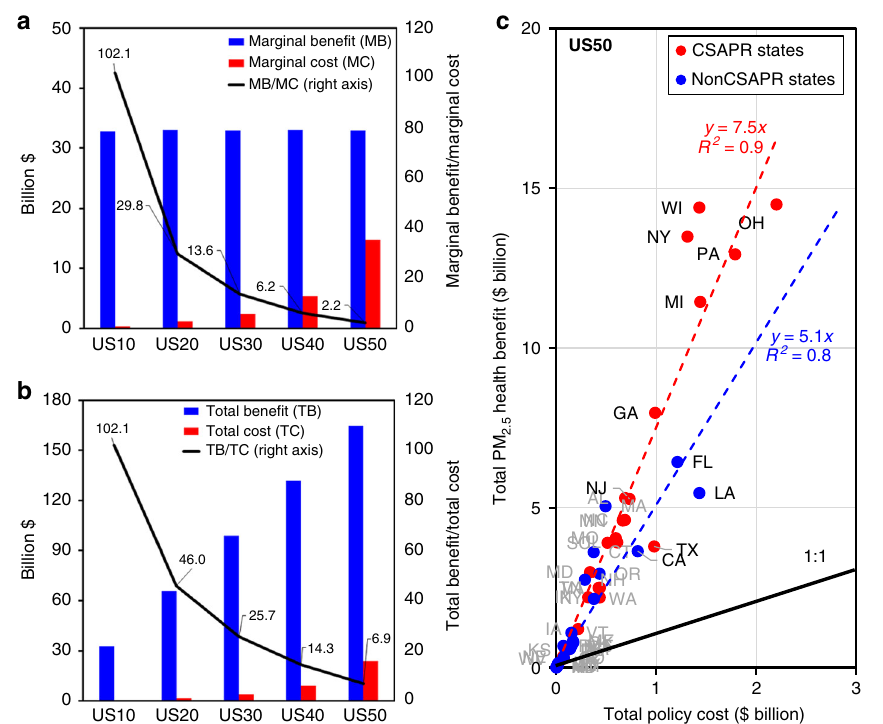
Fig. 6 Cost-effectiveness of PM 2.5 mortality cost reductions. Marginal PM 2.5 health bene fi t and marginal policy cost ( a ), total PM 2.5 health bene fi t and total policy cost ( b ) under PM 2.5 mortality cost reductions in 2050, and state-level estimates of total PM 2.5 health bene fi t and policy cost in US50 in 2050 ( c ). Source data are provided as a Source Data fi period modeled in GCAM-USA (2010 to 2050 in 5-year increments) to account for future changes in population exposure, baseline mortality rates, and VSL 19 (Supplementary Table 23). The state-level mortality costs presented here represent the impact of emissions from that state on the population within that state and all downwind states. State-level PMMC coef fi cients for all sectors vary widely across states (Supplementary Table 4). Our previous research 21,22 demonstrated that